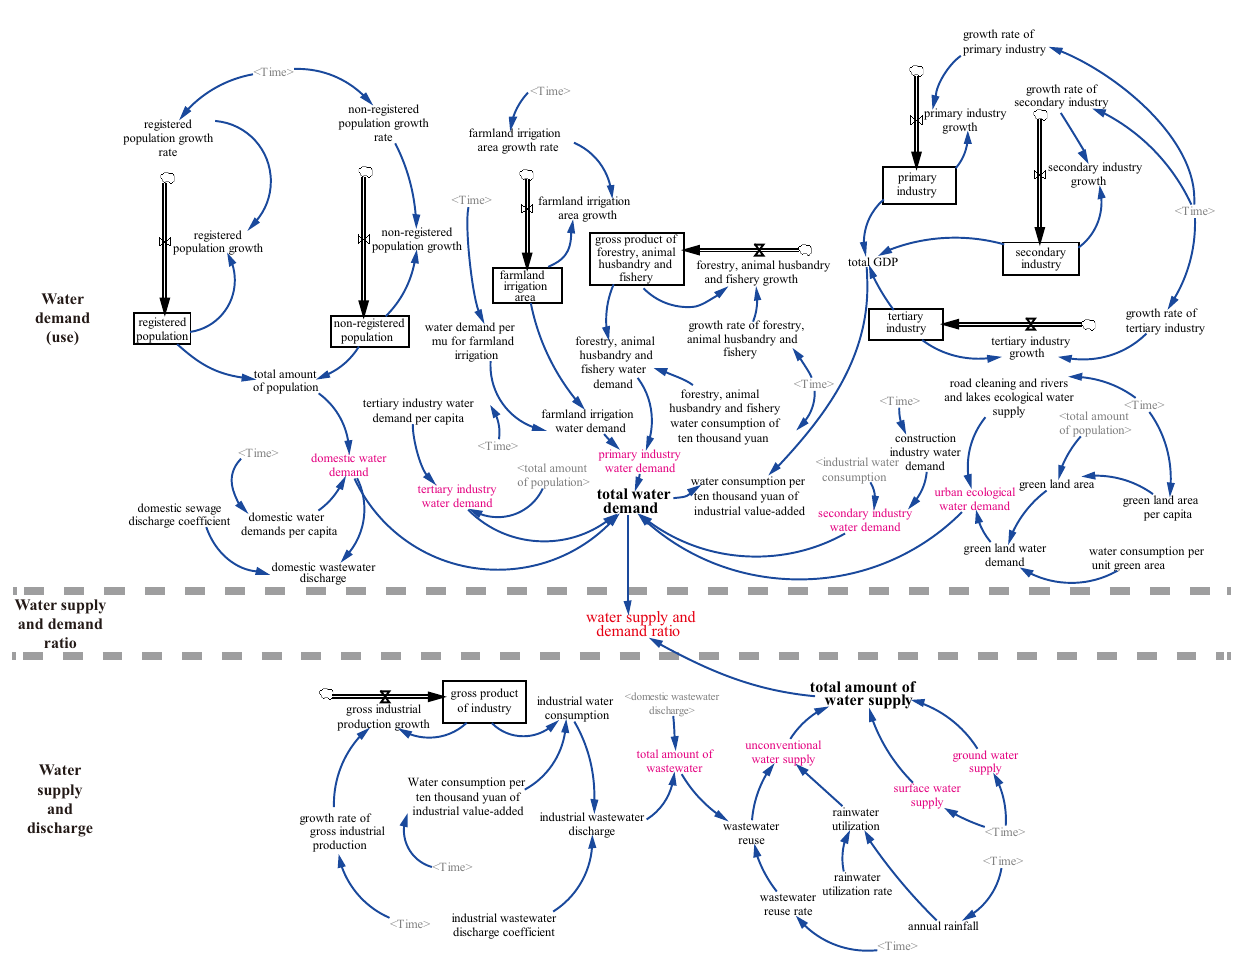
Fig 3. Diagram of Chengdu water resources supply and demand